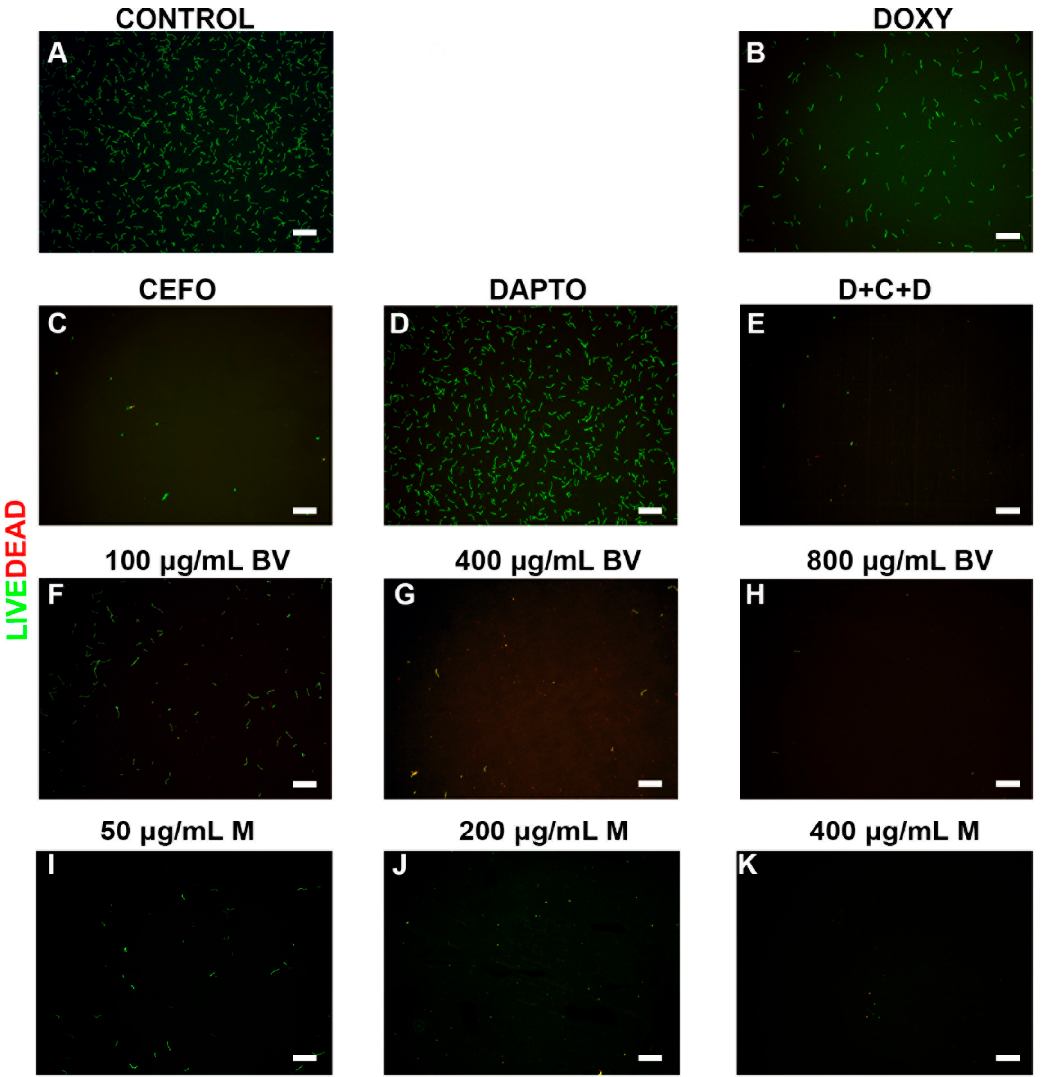
Figure 2. Representative Live/Dead staining images of B. burgdorferi log phase spirochetal cultures treated with different antimicrobial agents. Cells were stained with SYBR Green I/PI as outlined in the Methods and representative images were taken at 100 × magnification. Panel ( A ) Borrelia culture treated only with PBS was used as a negative control. Panel ( B ) Doxycycline (DOXY) treated; Panel ( C ) Cefoperazone (CEFO) treated; Panel ( D ) Daptomycin (DAPTO) treated and Panel ( E ) Three-antibiotic combination (D + C + D). Panels ( F – H ) Bee venom (BV) was used in increasing concentrations while Panels ( I – K ) depicts melittin (M) treated cells. Live cells are stained with green color while dead cells are stained red. Scale bar: 100 μ m.